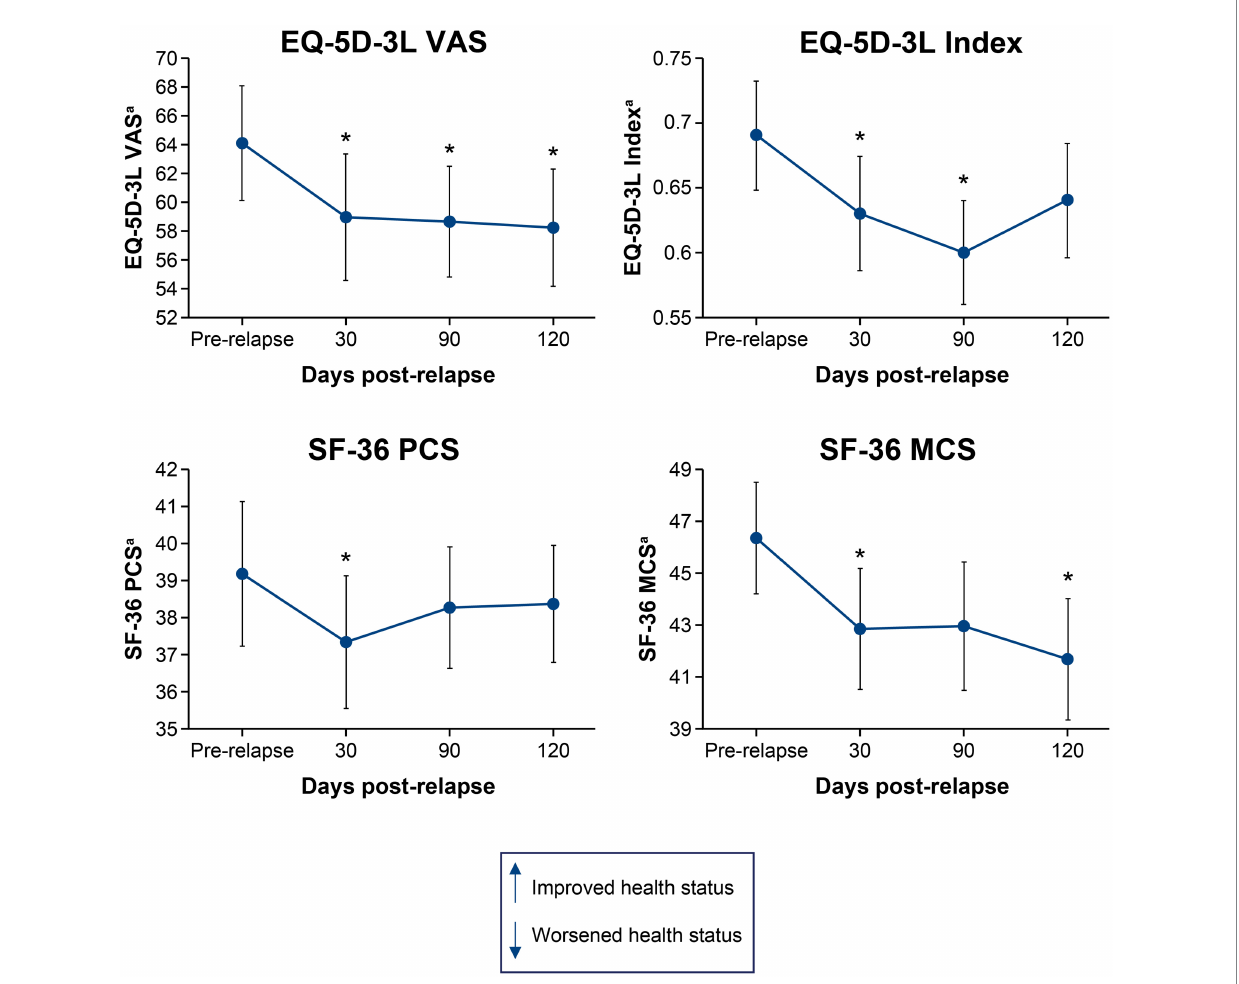
FIGURE 2 Mean change in EQ-5D-3L VAS, EQ-5D-3L Index, SF-36 PCS, and SF-36 MCS scores from pre-relapse to 30, 90, and 120 days post-relapse. * p < 0.05 for the mean change from pre-relapse to post-relapse. a Lower scores indicate worsened health status. EQ-5D-3L, European Quality of Life 5-Dimension questionnaire 3-Level; HRQoL, health-related quality of life; MCS, mental component summary; PCS, physical component summary; SF-36, 36-Item Short-Form Health Survey; VAS, visual analogue